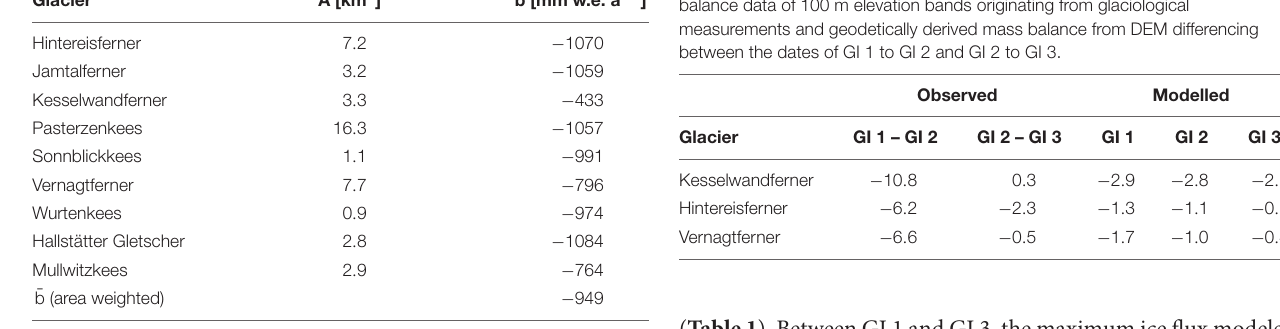
TABLE 4 | Observed average glacier mass balances between GI 3 and 2016. Glacier